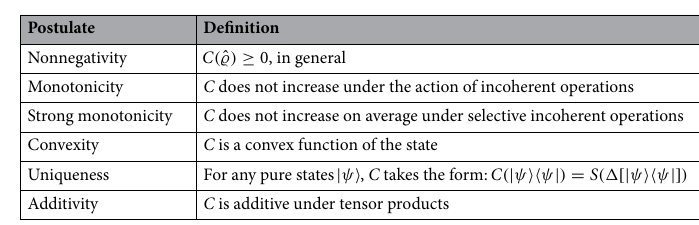
Table 1. Requirements for a coherence measure C d ( ˆ ̺) . S is von Neumann entropy and (cid:31) represents the dephasing